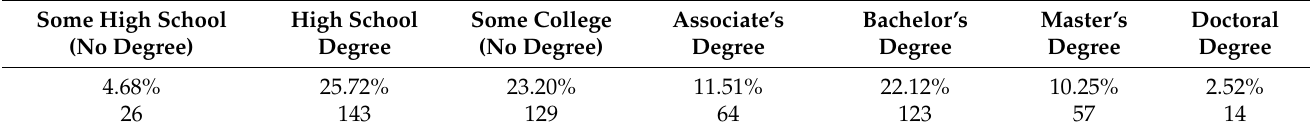
Table 3. Respondents’ education distribution [20].